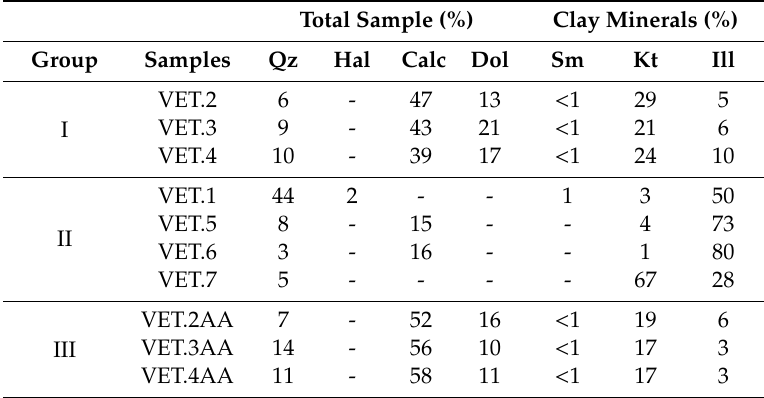
Table 2. Mineralogical composition (%).